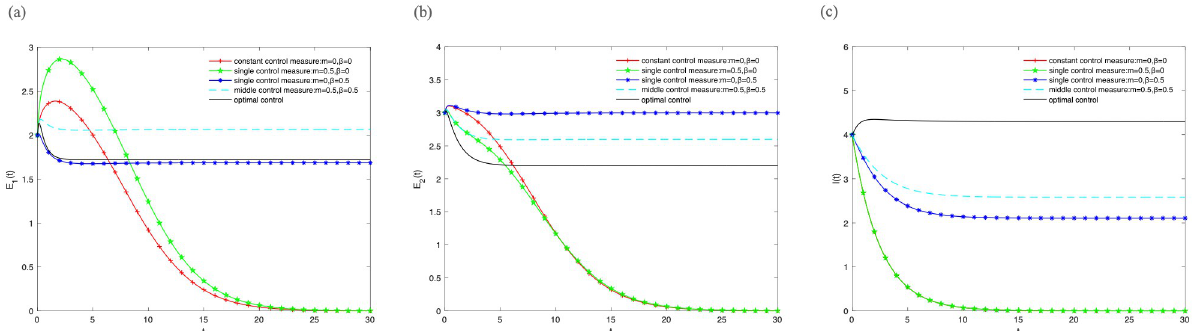
Fig 5. The densities of (A) E 1 ( t ), (B) E 2 ( t ), (C) I ( t ) change over time under different control strategies, where B = 5, α = 0.8, μ = 0.2, γ 1 = 0.5, γ 2 = 0.7, ε = 0.2, λ =